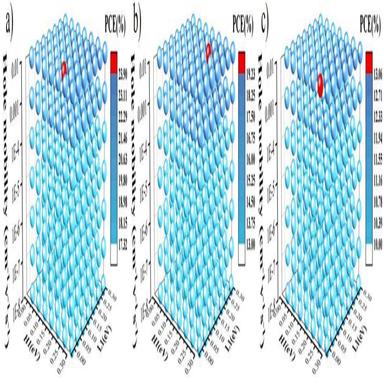
High-throughput screening of hole mobility and energy level alignment for three perovskite devices by ML. a) middle bandgap device: FAPbI3. b) narrow bandgap device: FAPb0.5Sn0.5I3. c) wide bandgap device: CsPbBr3.